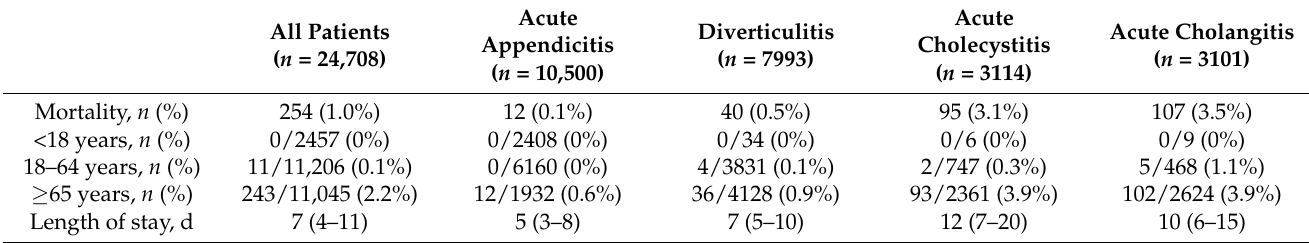
Table 2. Outcome